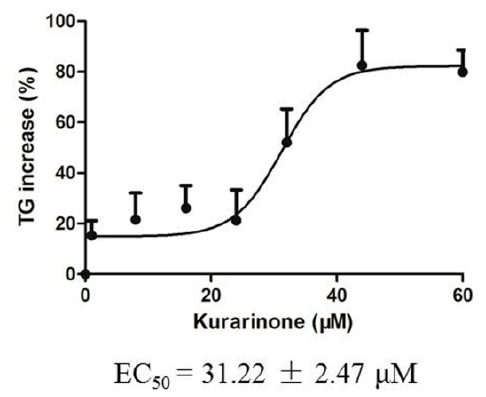
Figure 7. Increase of triglyceride in HL 7702 cells exposed to kurarinone for 24 h.